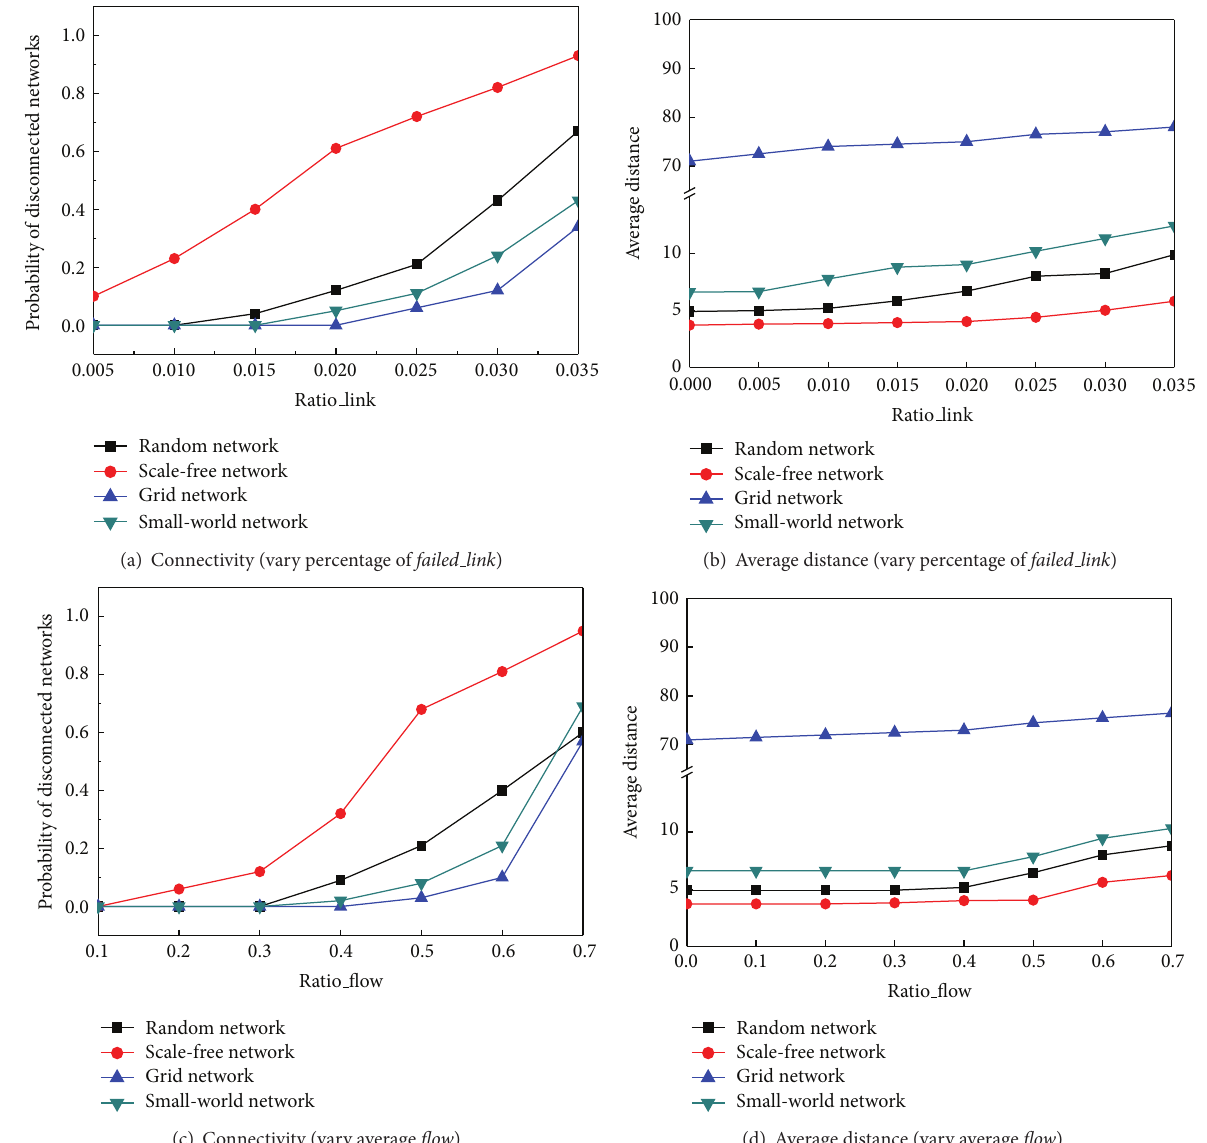
Figure 3: Connectivity and average distance by varying Ratio link and Ratio flow